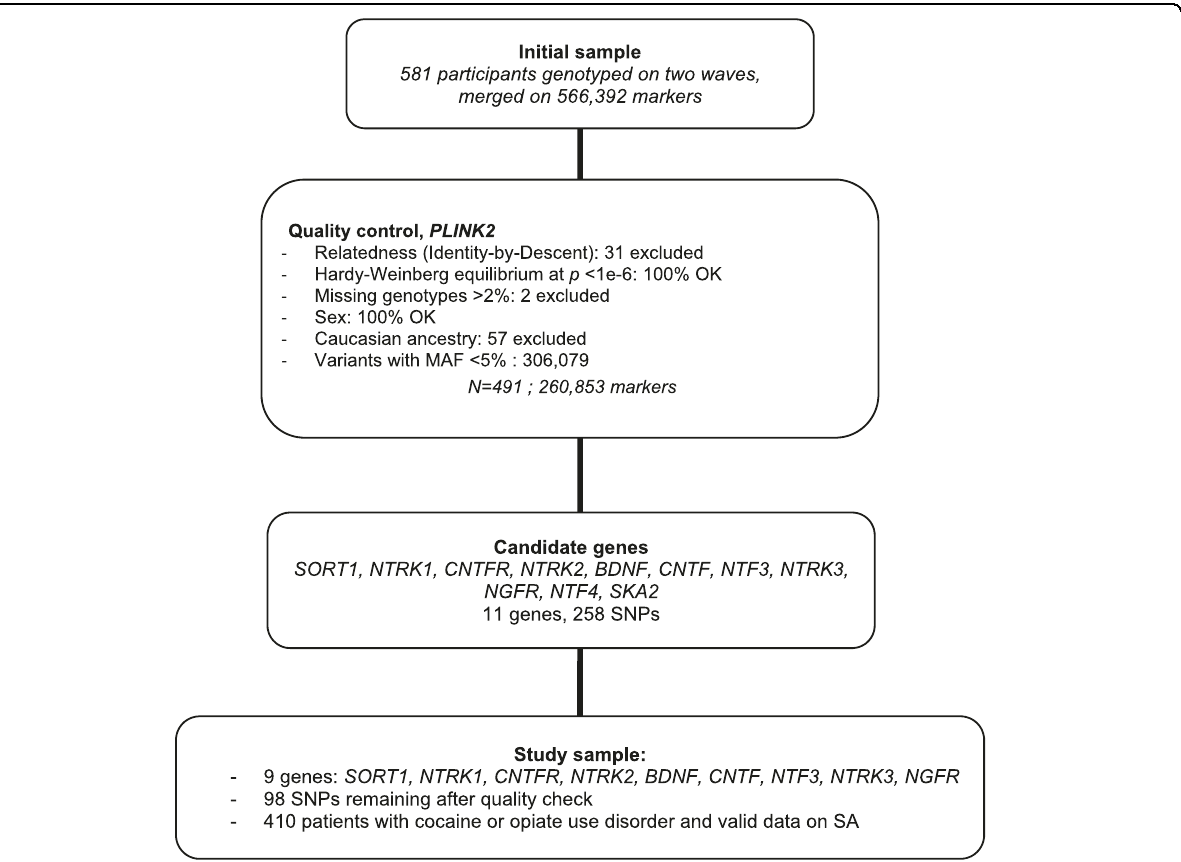
Fig. 1 Study fl owchart for sample and SNP selection. MAF, minor allele frequency; SNP, single nucleotide polymorphism; SA, suicide